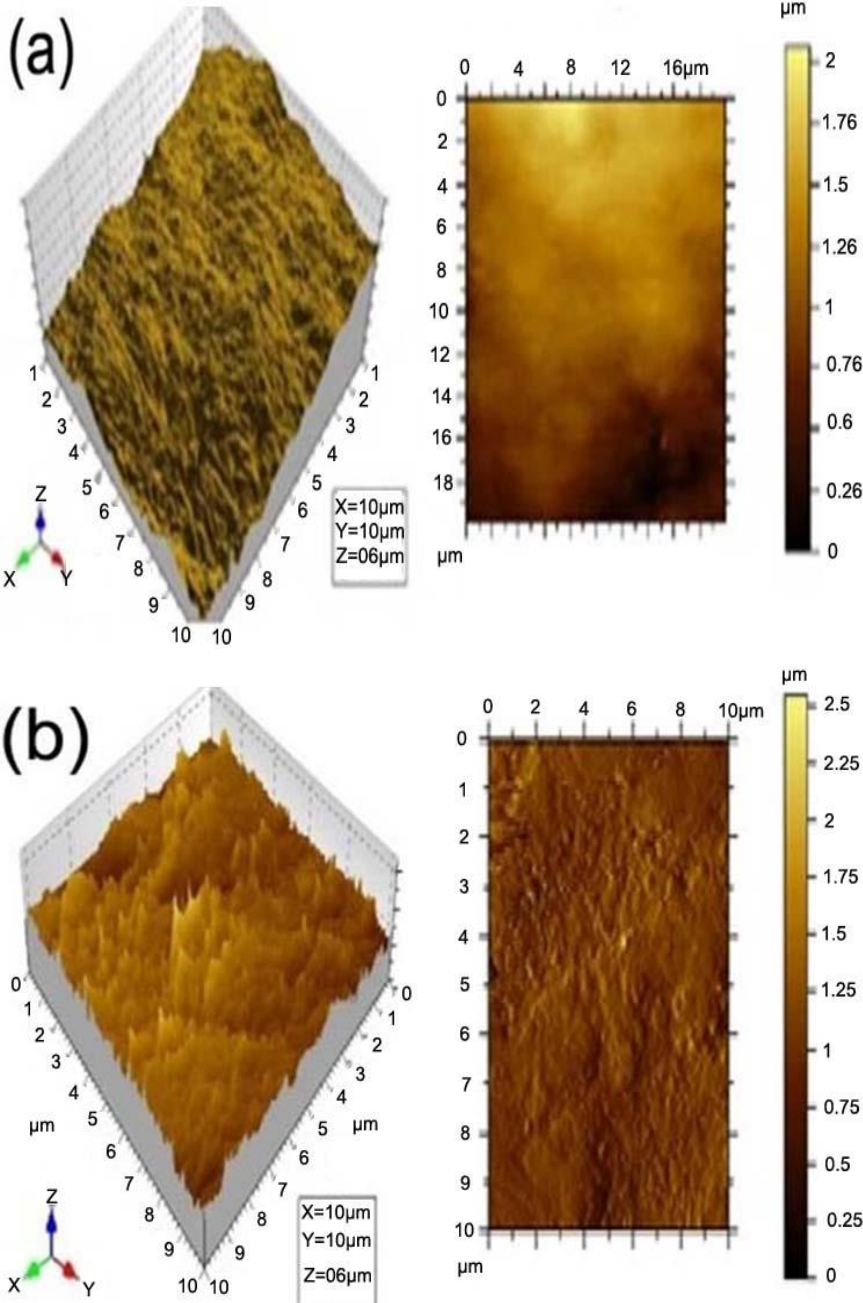
Figure 12. AFM image of the eroded surface of the substrate and coatings at low and high standoff distances. ( a ) Velocity: 30 m/s, angle: 60 ◦ , distance: 30 mm, erodent discharge: 2500 g/min; ( b ) velocity: 30 m/s, angle: 60 ◦ , distance: 50 mm, erodent discharge: 2500 g/min.